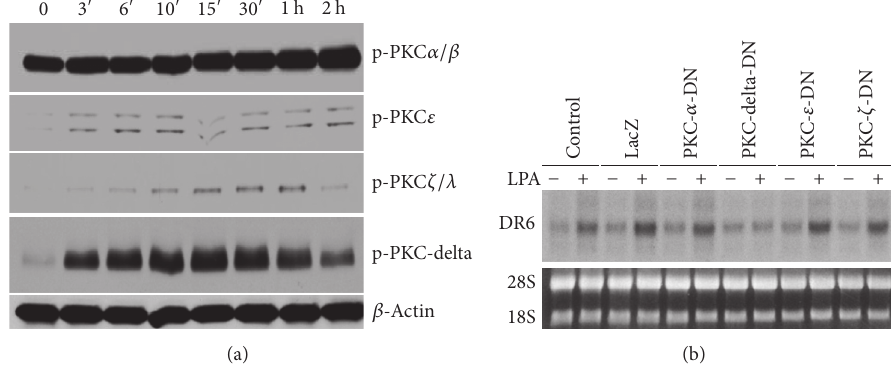
Figure 5: LPA-induced DR6 upregulation is specifically mediated by PKC 𝛿 isoform. (a) A time course of LPA-induced activation of PKC kinases.TheblotswereincubatedinsequencewithantibodiesagainstseveralmajorPKCisoformssuchasPKC 𝛼 / 𝛽 ,PKC 𝜀 ,PKC 𝜁 / 𝜆 ,andPKC 𝛿 . All isozymes stained as a dominant band of the expected molecular weight. 𝑛 = 3 . (b) HeLa cells were infected with adenoviral PKC 𝛼 -DN, PKC 𝛿 -DN, PKC 𝜀 -DN, and PKC 𝜁 -DN for up to 24 hrs. Cells were then starved in DMEM serum-free overnight and stimulated with 25 𝜇 M LPA (+) or vehicle ( − ) for 8 hrs, followed by Northern blotting for DR6 mRNA expression. 𝑛 = 3 .